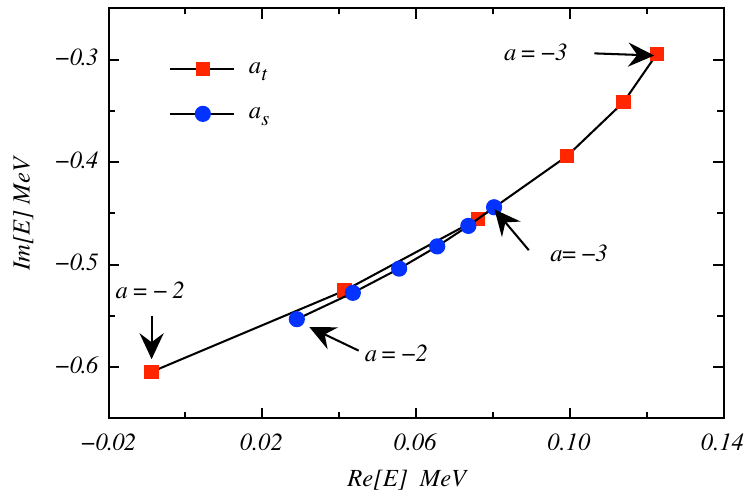
Figure 4: Variation in the position of the Λ nn pole as one varies either the singlet scattering length a (fm) or the triplet scattering length a s teraction is a Yamaguchi potential based upon the Nijmegen Model D [ 11 ] , with a scaling strength factor s =